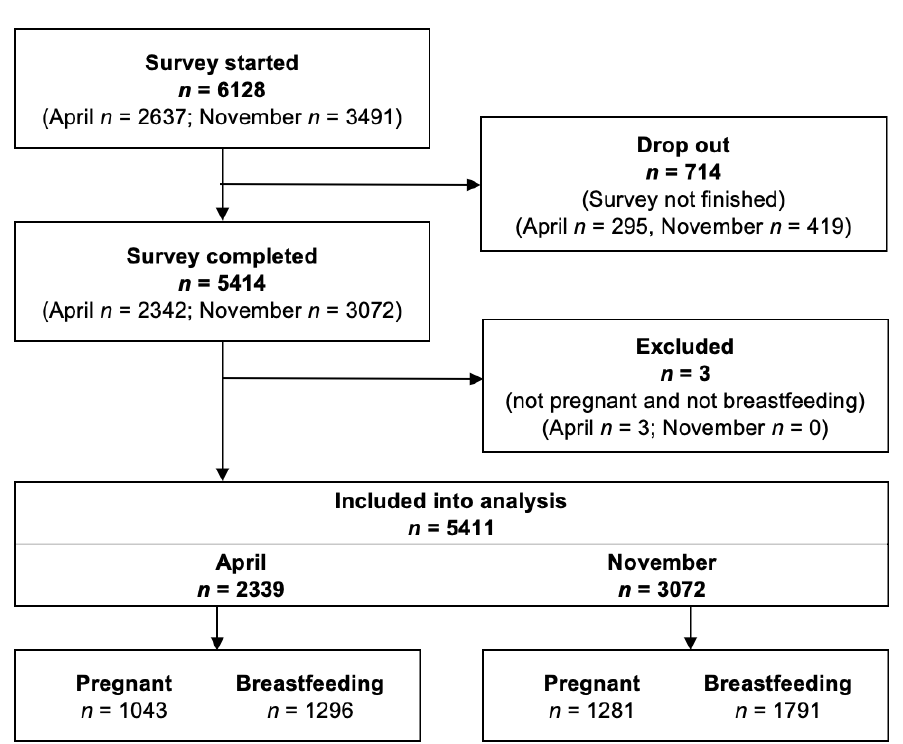
Figure 1. Flow chart of the study sample. Table 1. Characteristics of pregnant and breastfeeding women.